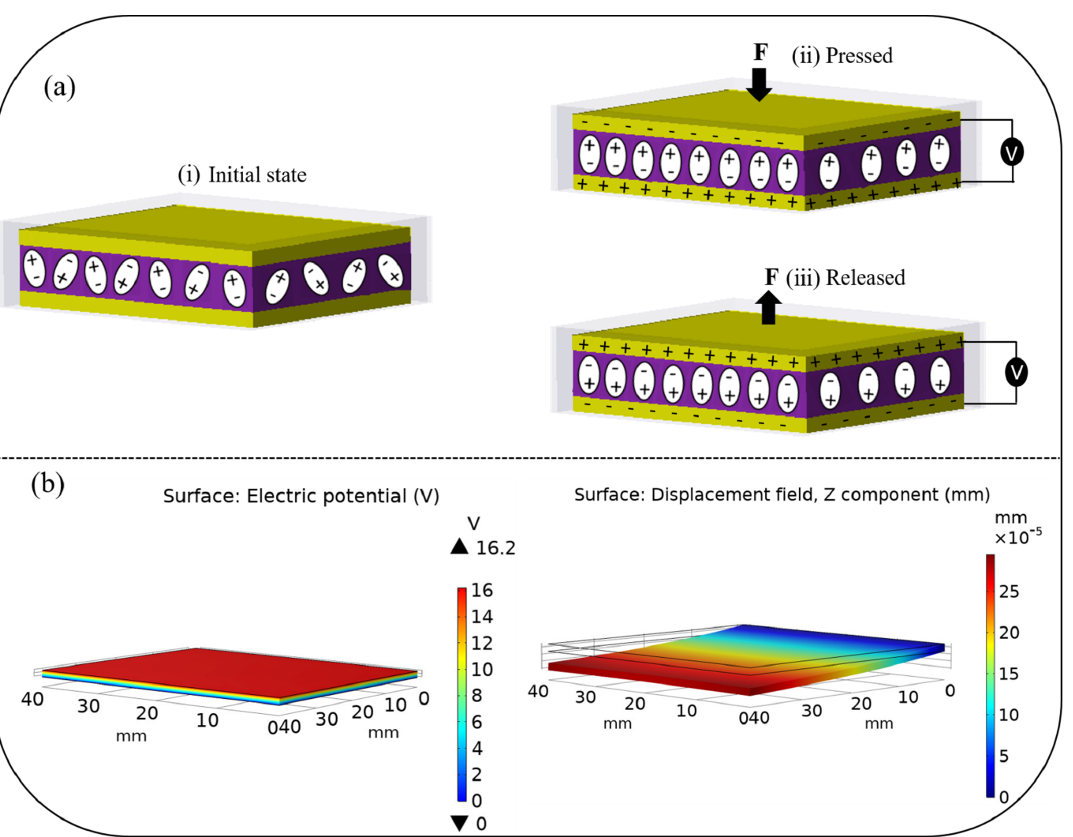
Figure 6. ( a ) Direct piezoelectric effect, the working mechanism of the piezoelectric device; ( b ) Com ‐ sol simulation of the reverse piezoelectric effect.